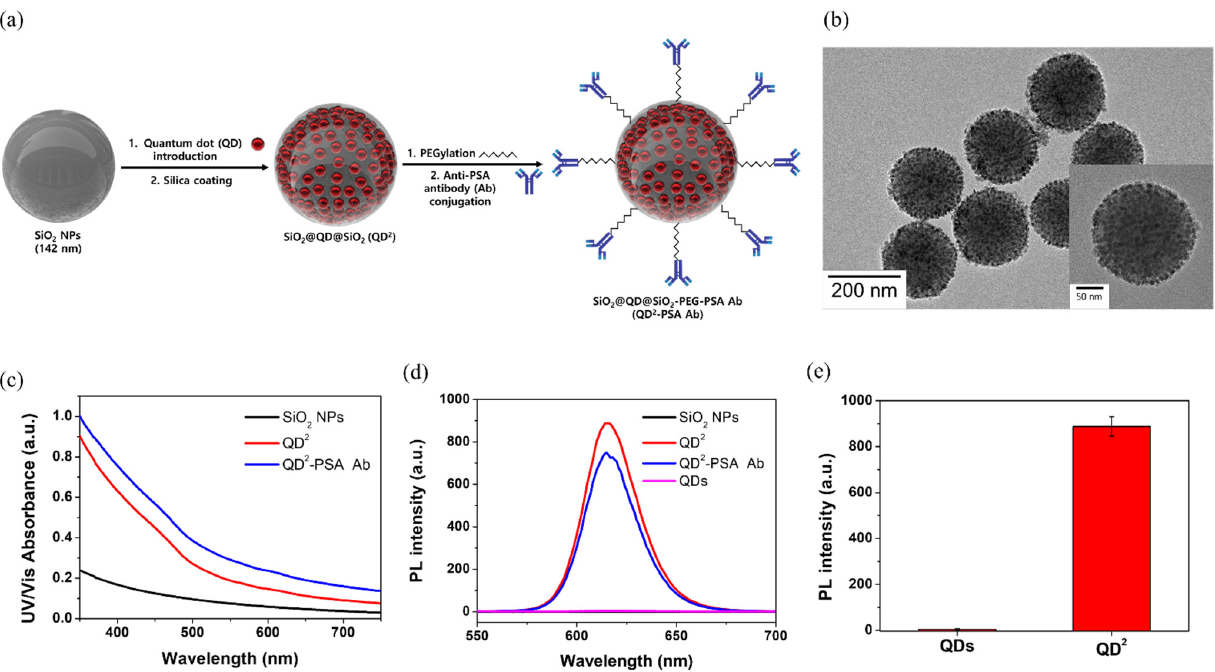
Figure 1. ( a ) Schematic illustration of QD 2 -PSA Ab fabrication (this figure is not drawn to scale); ( b ) transmission electron microscopy (TEM) images of QD 2 . The inset depicts individual QD 2 ; ( c ) UV–Vis absorbance of SiO 2 NPs, QD 2 , and QD 2 -PSA Ab; ( d ) PL intensity of SiO 2 NPs, QD 2 , and QD 2 -PSA Ab; ( e ) PL intensity comparison between QDs and QD 2